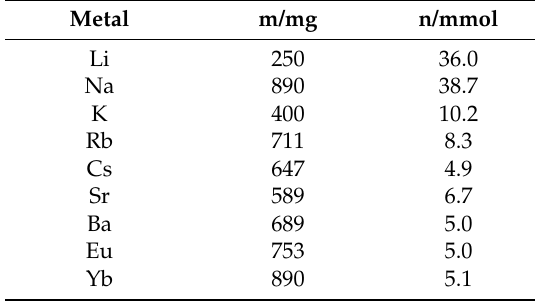
Table 3. Amounts of alkali, alkaline earth and rare earth metals used for reaction with SF 6 in liquid